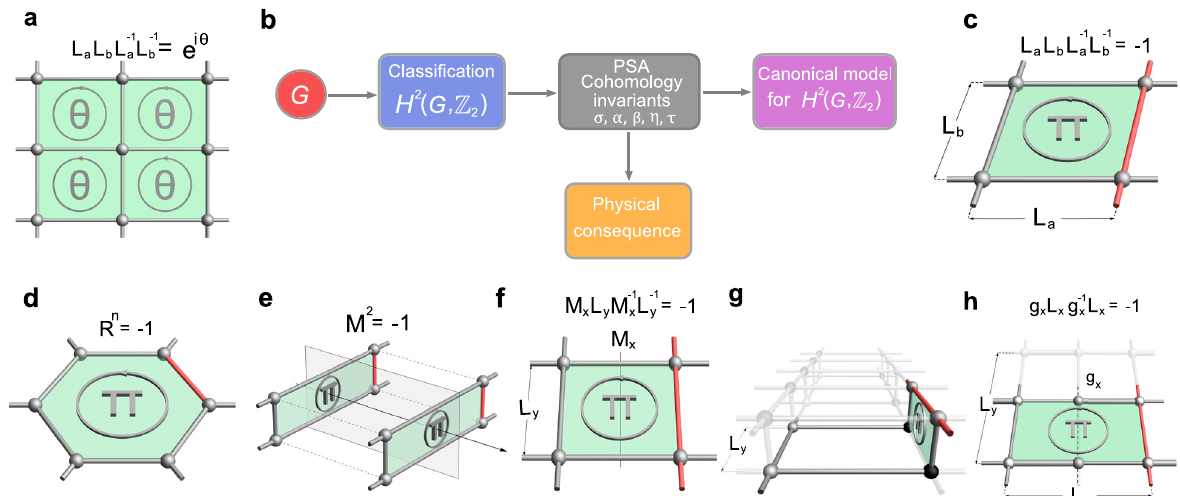
Fig. 1 | Logic chart and fl ux realizations of projective algebraic relations. a Gauge fl ux in a lattice requires the space group symmetries to be projectively represented. b Work fl ow diagram of this work. Given a space group G , the classi- fi cationofprojectiverepresentationsaregivenby H 2 ð G , Z 2 Þ .Theserepresentations are captured by projective symmetry algebras (PSAs) with a complete set of rectangularplaquettesisrequiredtobe π .Here,the π fl cohomologyinvariants,fromwhichweconstructacanonicalmodelthatcanrealize all possible PSAs, and derive nontrivial physical consequences. c – h Illustrate the